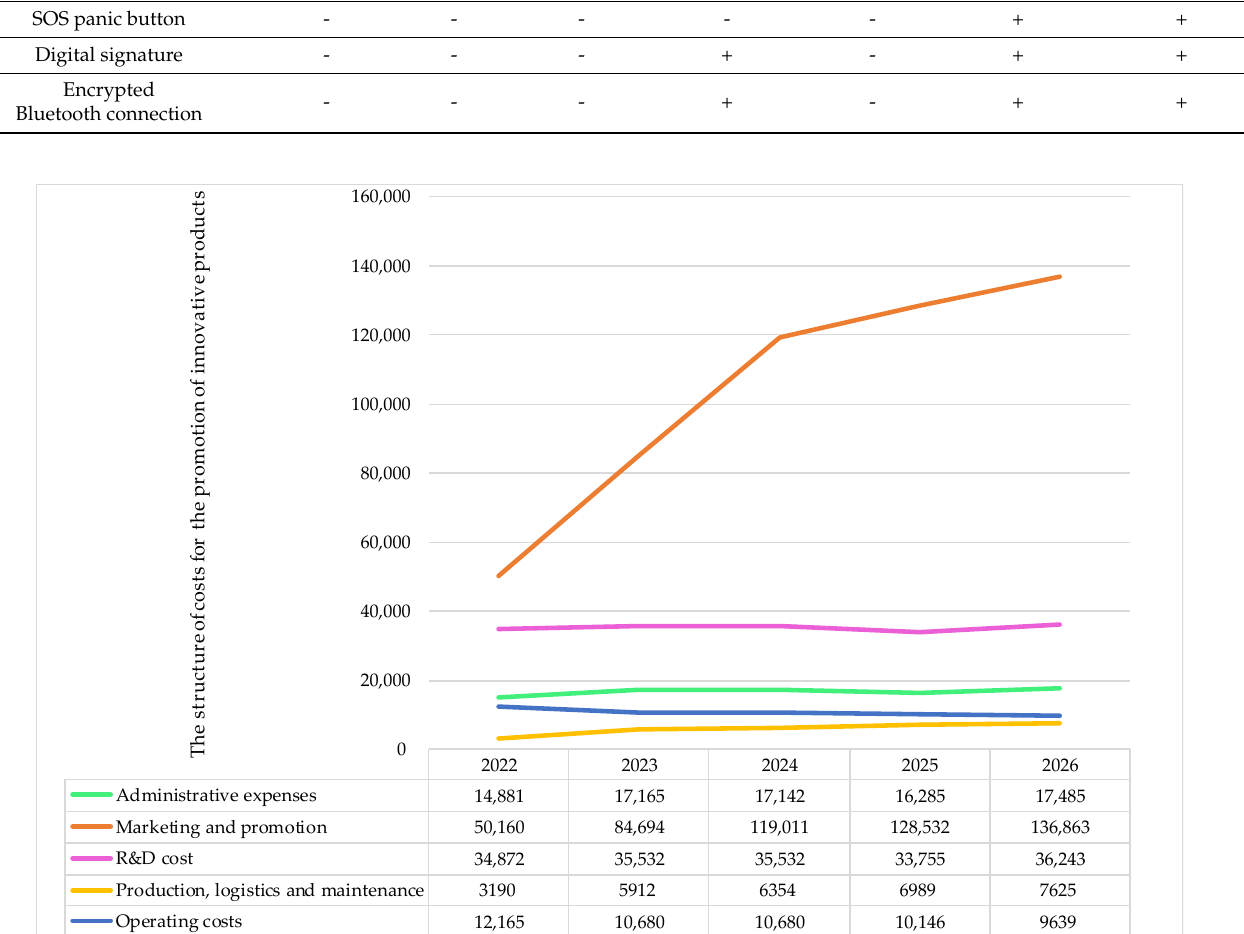
Figure 4. The structure of expenses for the promotion of innovative products of Hideez in the dynamics during 2022–2026, US dollars.